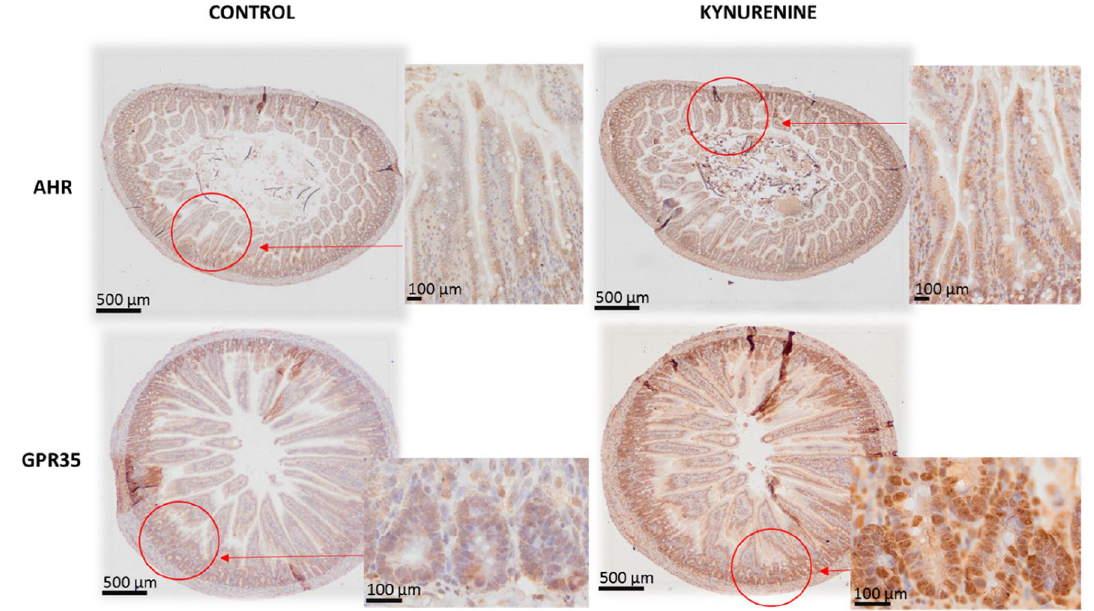
Figure 2. Representative photomicrographs of the immunohistochemical reactions for AhR and GPR35 in the jejunum of rats treated with kynurenine during maternal feeding. Sections were developed in 3,3 ′ -diaminobenzidine tetrahydrochloride (DAB); counterstaining was performed with Mayer’s